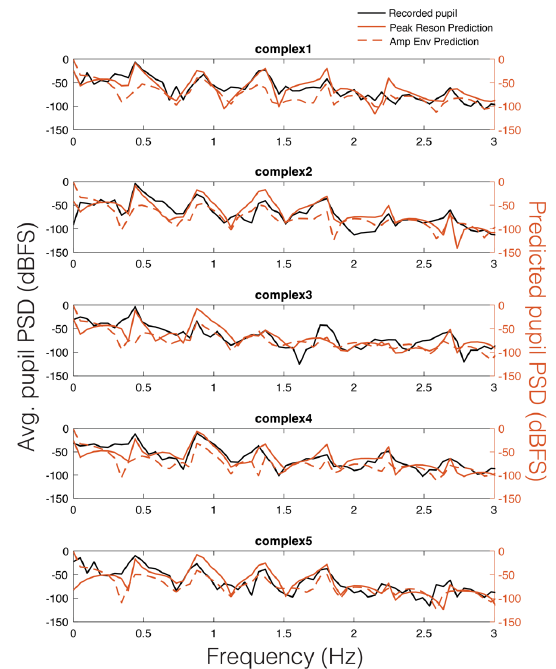
Figure 5. Average pupillary responses, across all partic- ipants, to 8-loop epochs of each stimulus (black), com- pared to the peak reson filter model-predicted pupillary re- sponses (solid red) and the amplitude envelope-predicted pupillary responses (dotted red).